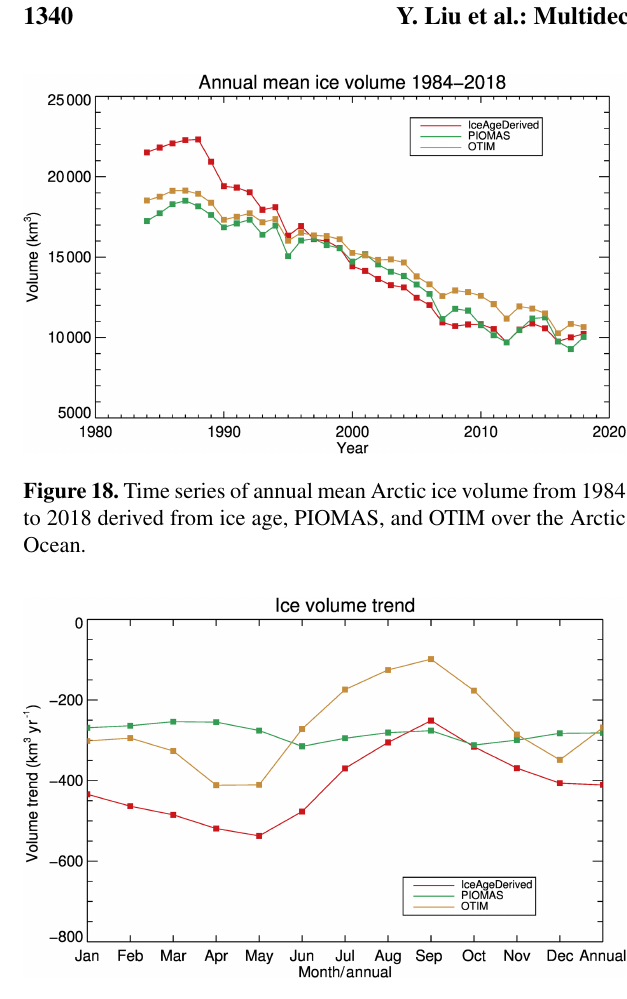
Figure 19. Trend of Arctic ice volume in each month and in the annual mean from 1984 to 2018 derived from ice age, PIOMAS, and OTIM over the Arctic Ocean.